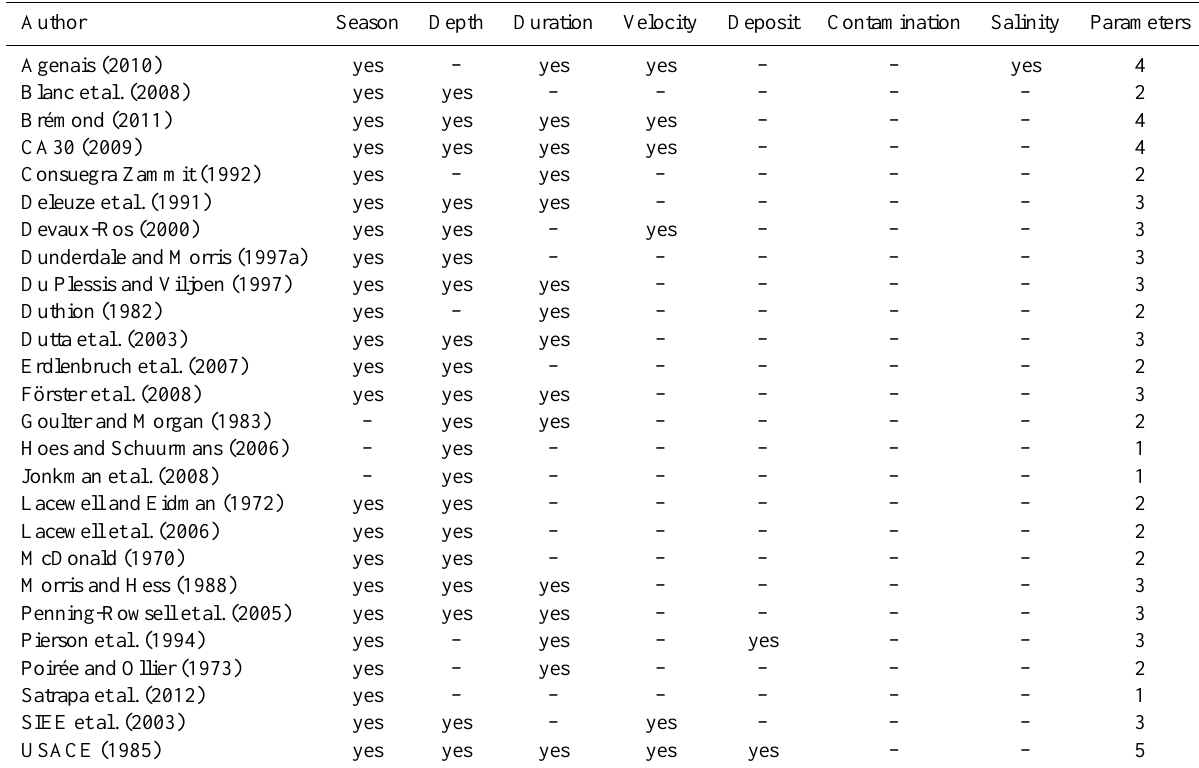
Table 4. Flood hazard parameters taken into account to evaluate crop damage in the studies